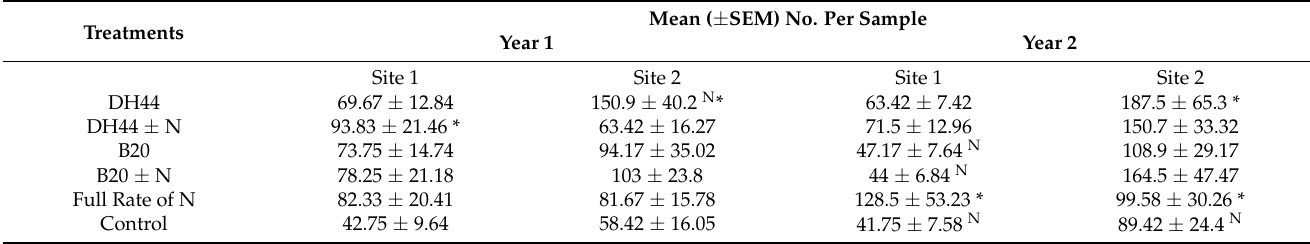
Table 3. Abundance of oribatid mites collected from bermudagrass forage plots treated with conven- tional fertility or biofertilization.